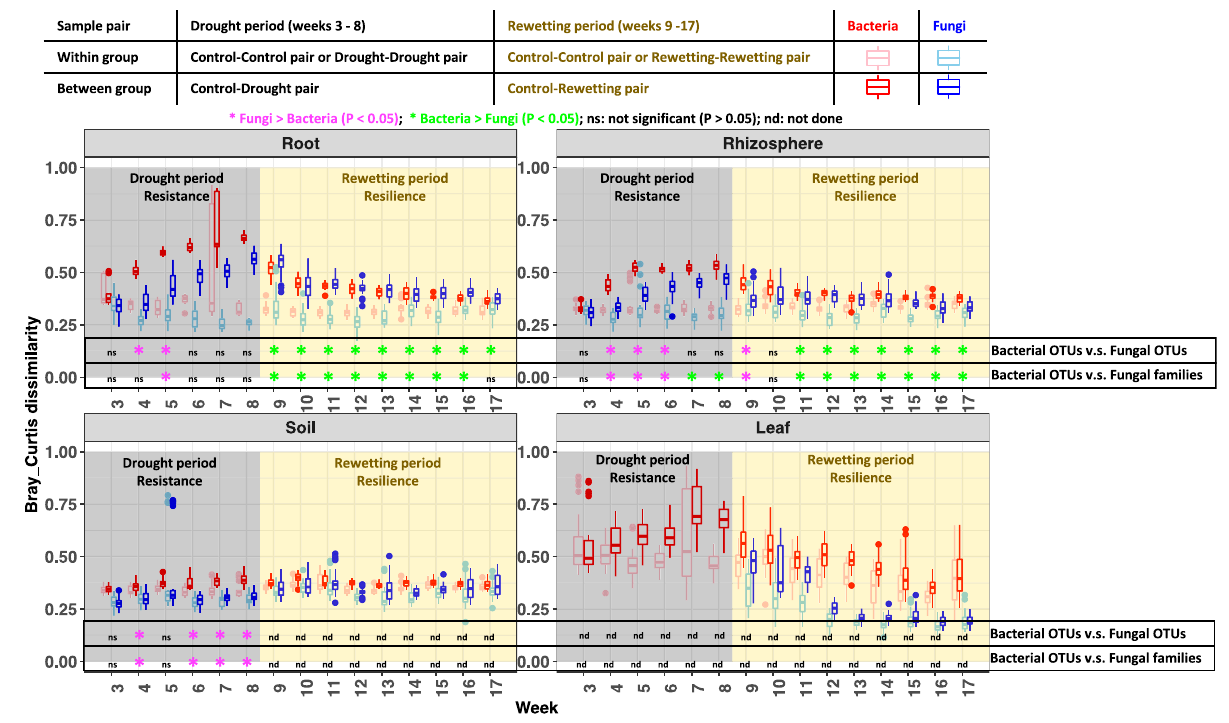
Fig. 1 Resistance and resilience of bacterial and fungal community composition. Bray-Curtis dissimilarities were computed for bacterial (red and light red) and fungal (blue and light blue) communities of four compartments (root, rhizosphere, soil, leaf) of n = 12 biologically independent plots examined over 17 weeks. The boxes represent the 25th – 75th percentiles (with the median as a horizontal line) and the whiskers show the 10th – 90th percentiles. Ecological resistance to drought stress is detected by comparing compositional dissimilarity of between-group pairs (control-drought pairs) against within- group pairs (control-control pairs and drought-drought pairs) at each of the droughted weeks (weeks 3 – 8, the grey shaded area) (* p < 0.05, adjusted by Bonferroni method; unpaired t-test, two-sided). Ecological resilience to rewetting is detected by assessing, from before, to after, rewetting, the change in the difference of compositional dissimilarity between within-group pairs and between-group pairs. Here, the point just before rewetting was week 8 and the points after rewetting were weeks 9 – 17 (the gold shaded area). To account for the different resolution of internal transcribed spacer (ITS) and 16 S, we compared bacterial 16 S operational taxonomic units (OTUs) against both fungal ITS OTUs, as well as fungal families. In 32 of 36 communities, the results of fungal families and OTUs are consistent. Different family and OTUs results were detected in two cases where signi fi cances detected by OTUs were not detected by family (root, weeks 4 and 17), and in two cases where signi fi cances detected by family were not detected by OTUs (rhizosphere, weeks 7 and 8). We report only results that are robust across these two conditions. Signi fi cantly higher resistance to drought of fungi than bacteria was detected in root (week 5), rhizosphere (weeks 4 – 6) and soil (weeks 4, 6 – 8). Signi fi cantly higher resilience to rewetting of bacteria than fungi was detected in root (weeks 9 – 16) and rhizosphere (weeks 11 – 17). Note that fungi exhibited stronger resilience than bacteria at the fi rst week of rewetting (week 9). The fi nding that fungal community composition in soil is not shaped by drought prevented us from further detecting resilience in this compartment. Note that fungal communities in early leaves are excluded from analysis due to the high proportion of non-fungal sequencing reads. The detailed results at fungal family levels can be found in Supplementary Fig. 1. Source data are provided as a Source Data fi